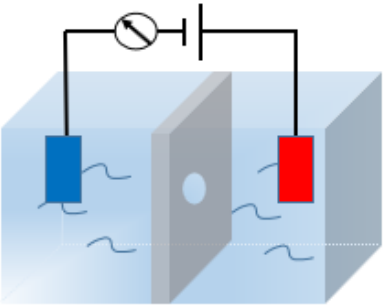
Figure 1. Nanopore detection principle.